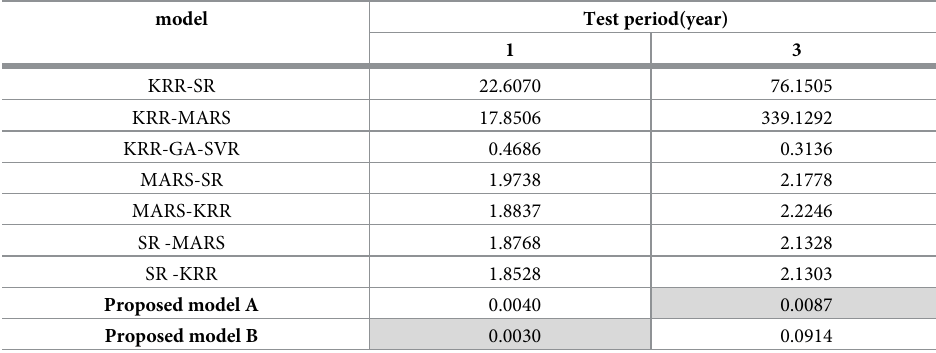
Table 10. Performance comparisons for Hon Hai.